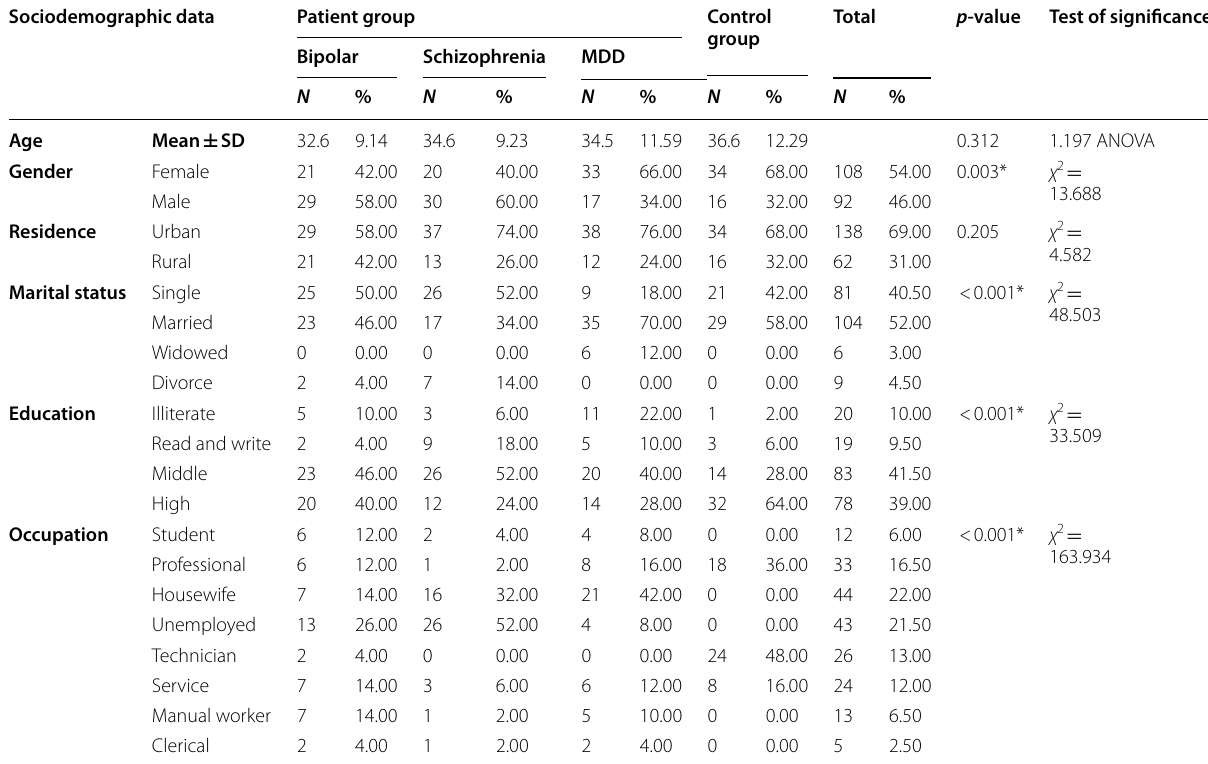
MDD Major depressive disorder, *statistically significant, SD Standard deviation